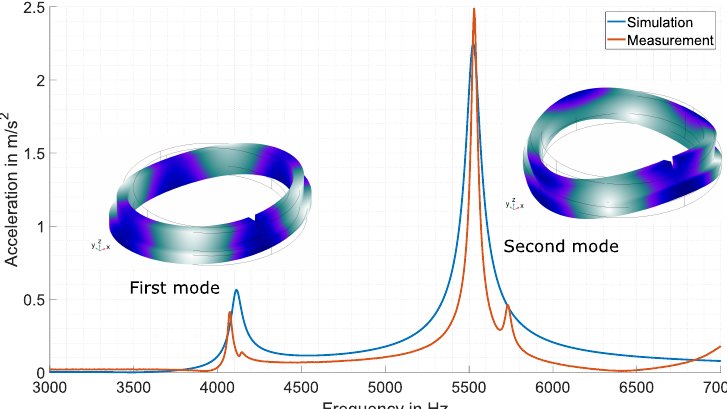
Figure 12. Measured frequency response and comparative simulation of the SiSiC ring. The mea- surement result proves the excitation of the first two modes by the EMAT. The simulation outcome confirms this observation, as the simulation shows overall agreement with the measurement. For a better illustration, the mode shape for each mode is plotted next to the corresponding